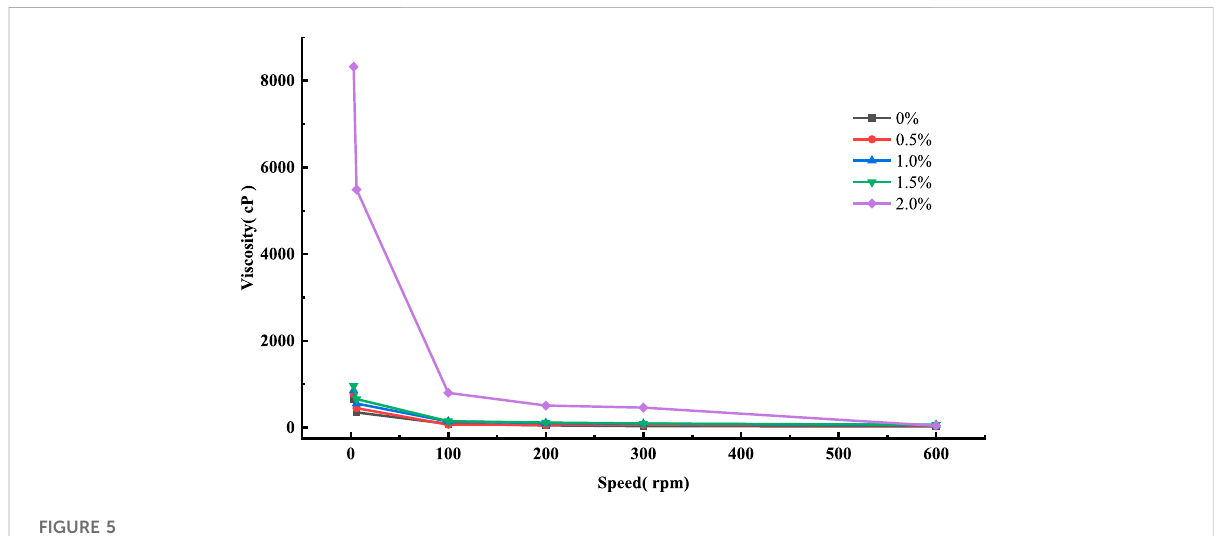
FIGURE 5 Comparison of viscosity at different rotating speeds under different concentrations of gel.